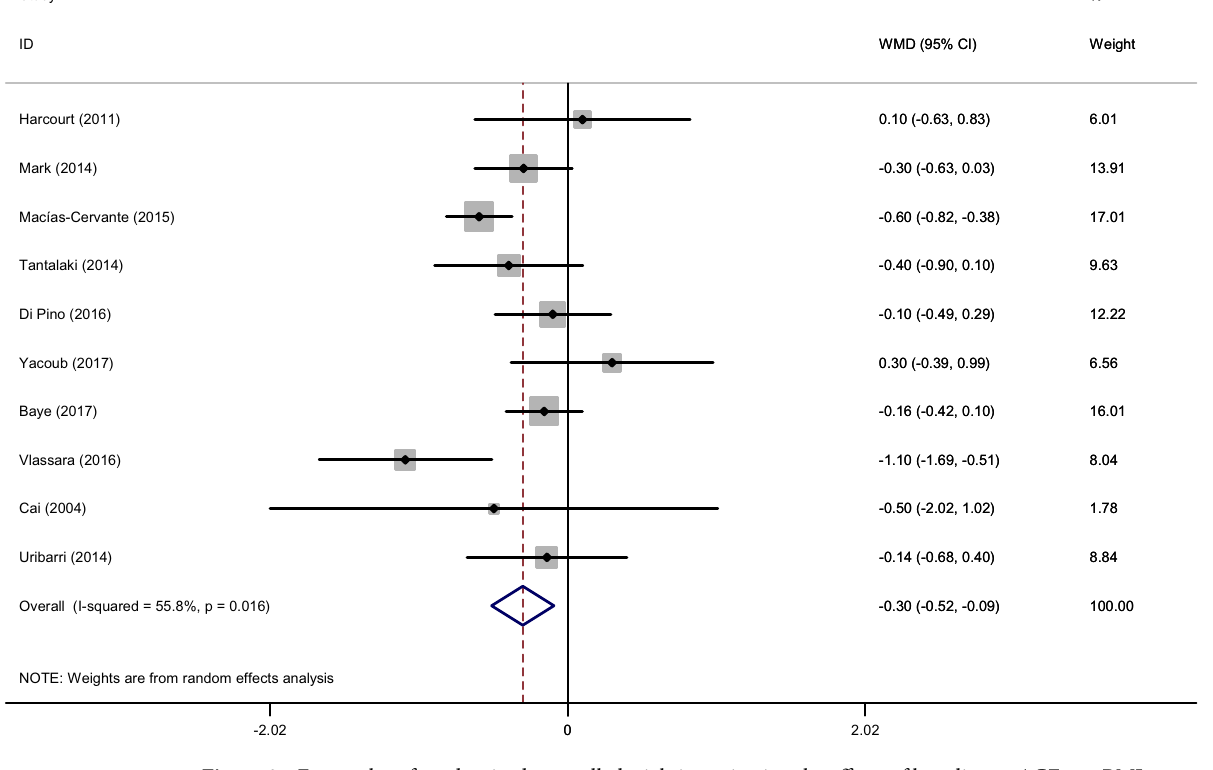
Figure 2. Forest plot of randomized controlled trials investigating the effects of low dietary AGEs on BMI.